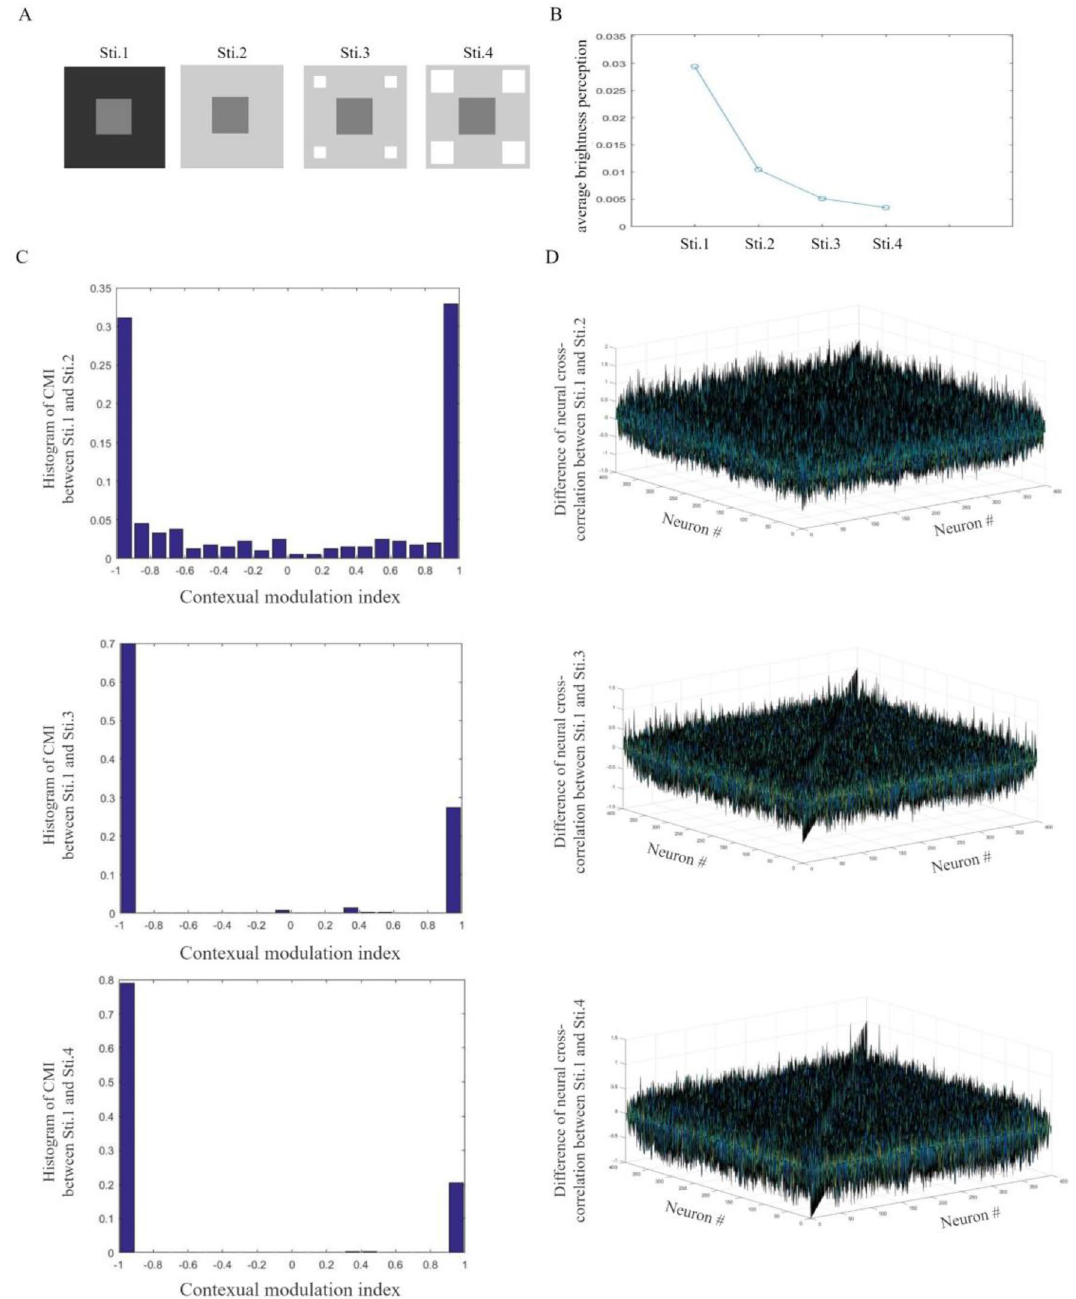
Figure 5. Brightness perception induced by sizes of distractors. ( A ) Images used as visual stimuli in our simulations. ( B ) Averaged brightness perception of target squares. For designed stimuli, perception of the same gray square is darker with bigger distractors. ( C ) The histogram of CMIs to stimuli. For designed stimuli, larger distractors could induce larger neural responding modulations. ( D ) Differences of excitatory neural responding cross-correlation to stimuli. A non-zero difference indicates the modulation of neural interactions induced by the varying size of